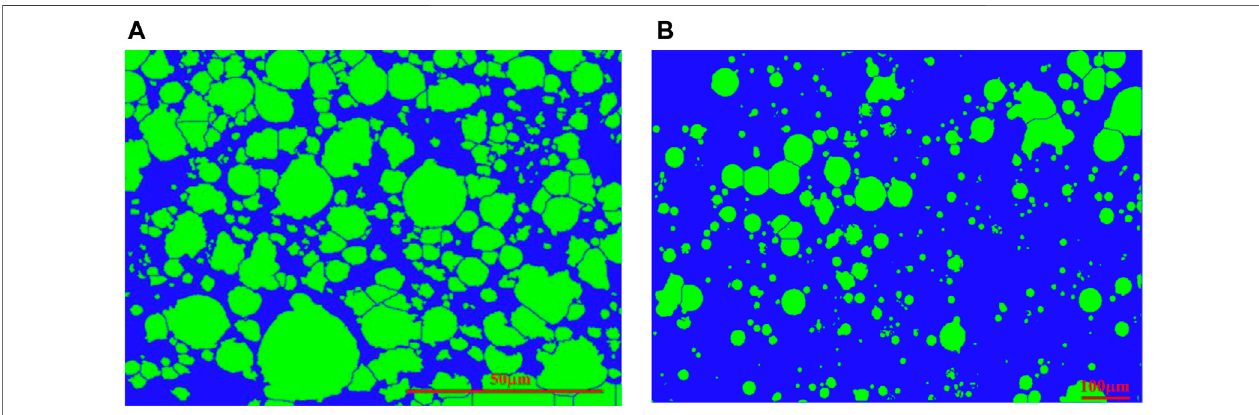
FIGURE 4 | PMs distribution at different hydration times after processing with ImageJ: (A) Hydration initial state; (B) Hydration time 1 day.